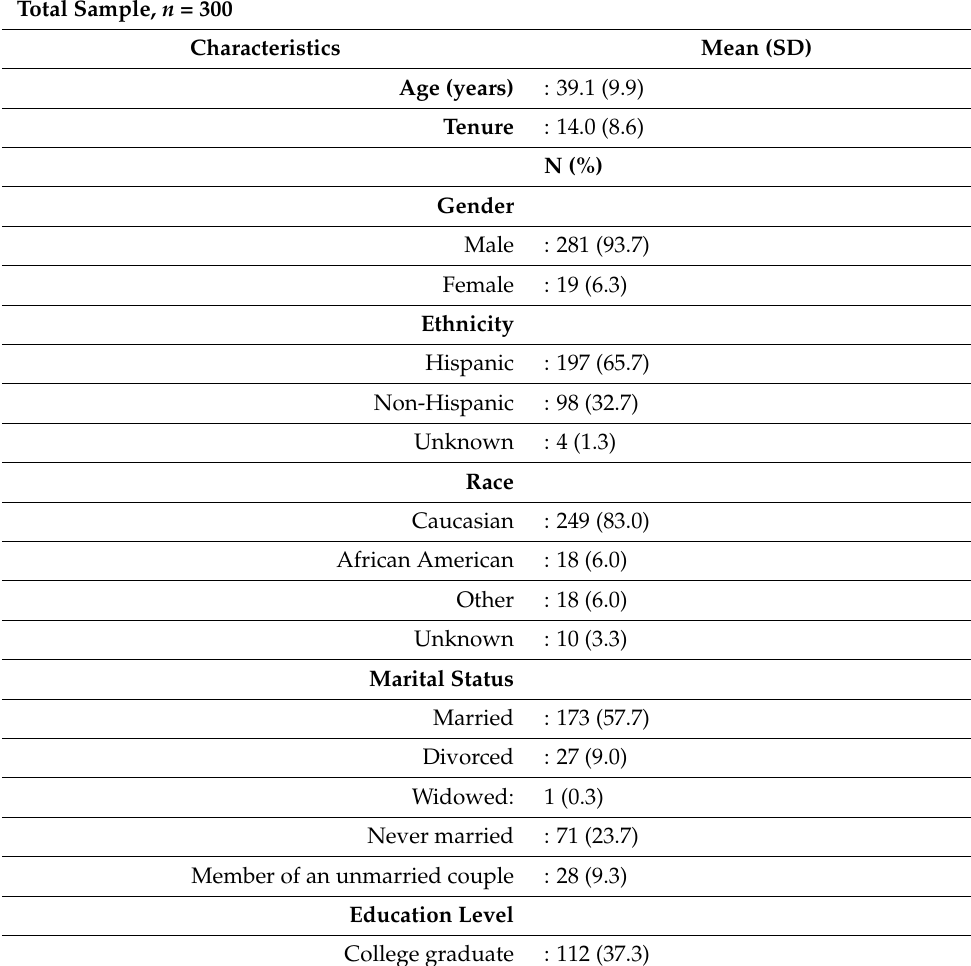
Table 1. Socio-demographic and work characteristics of the participating firefighters. Total Sample, n = 300